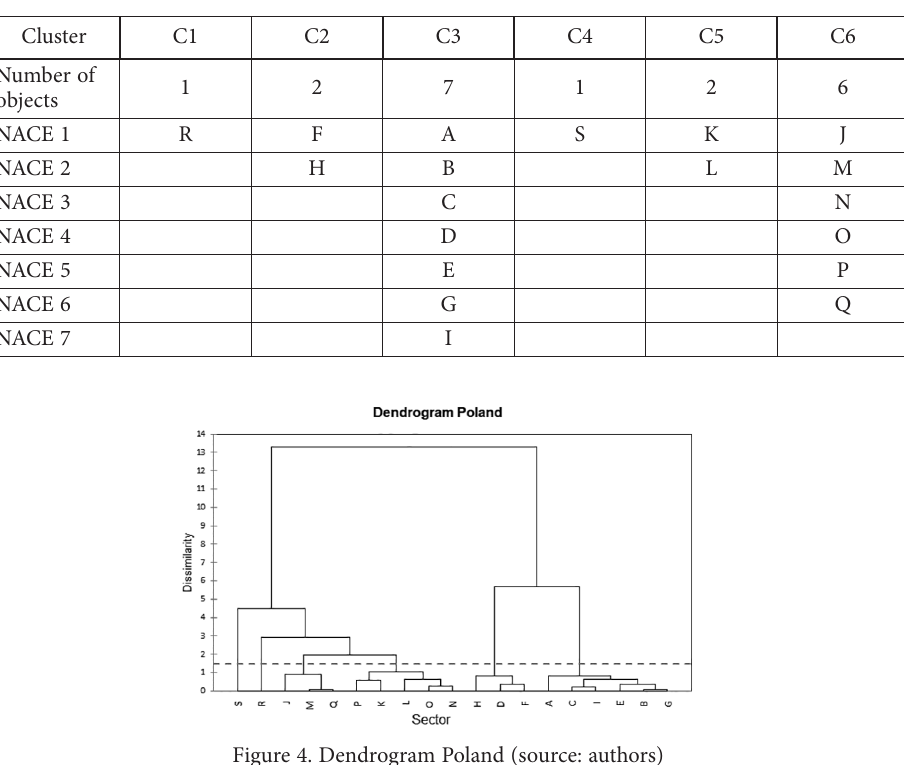
Figure 3. Dendrogram Hungary (source: authors) Table 5. Clusters of Hungary (source: authors)